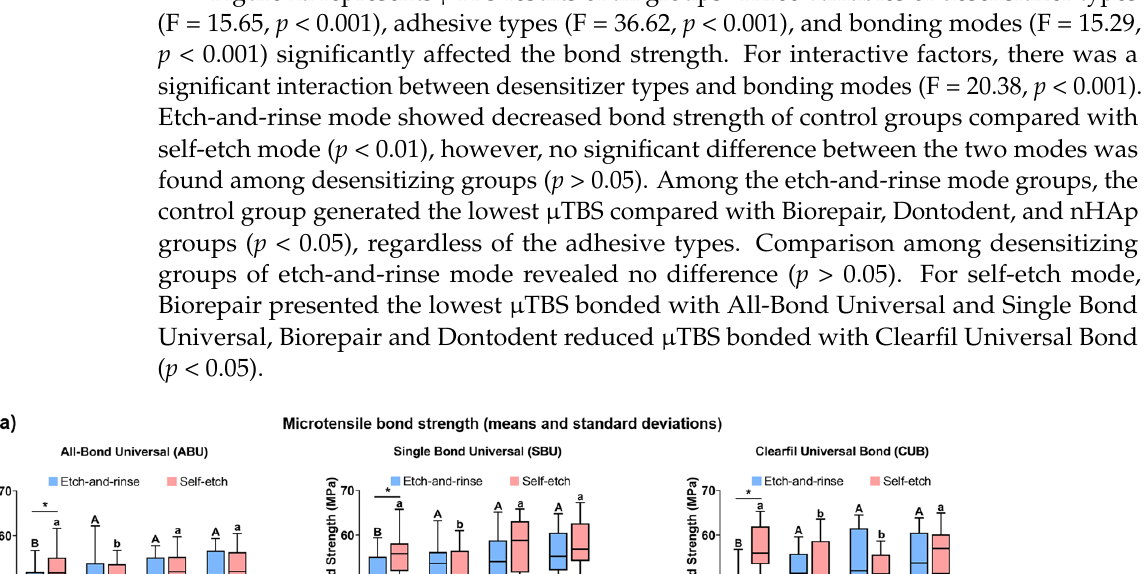
Figure 3 . General condition graphs (×90) and micrographs (×2000) of adhesive and mixed failure on dentin interfaces. ( a , b ) Mixed failure from control group bonded with etch-and-rinse mode; ( c , d ) adhesive failure from desensitizing groups bonded with self-etch mode; ( e , f ) typical adhesive failure; and ( g , h ) typical mixed failure. Circle: open dentin tubules; triangle: sealed dentin tubules; and solid arrowhead: resin tags. 3.2. Dentin Tubular Sealing Observation Dentin surfaces were free of a conspicuous smear layer, and the tubular orifices were all opened in the control group. After desensitization, the dentin surface was partially